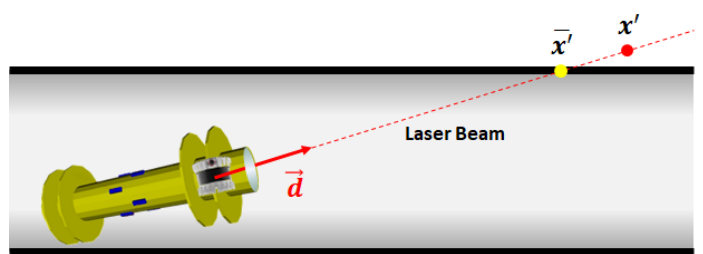
Figure 9. True and measured inner pipe wall points.